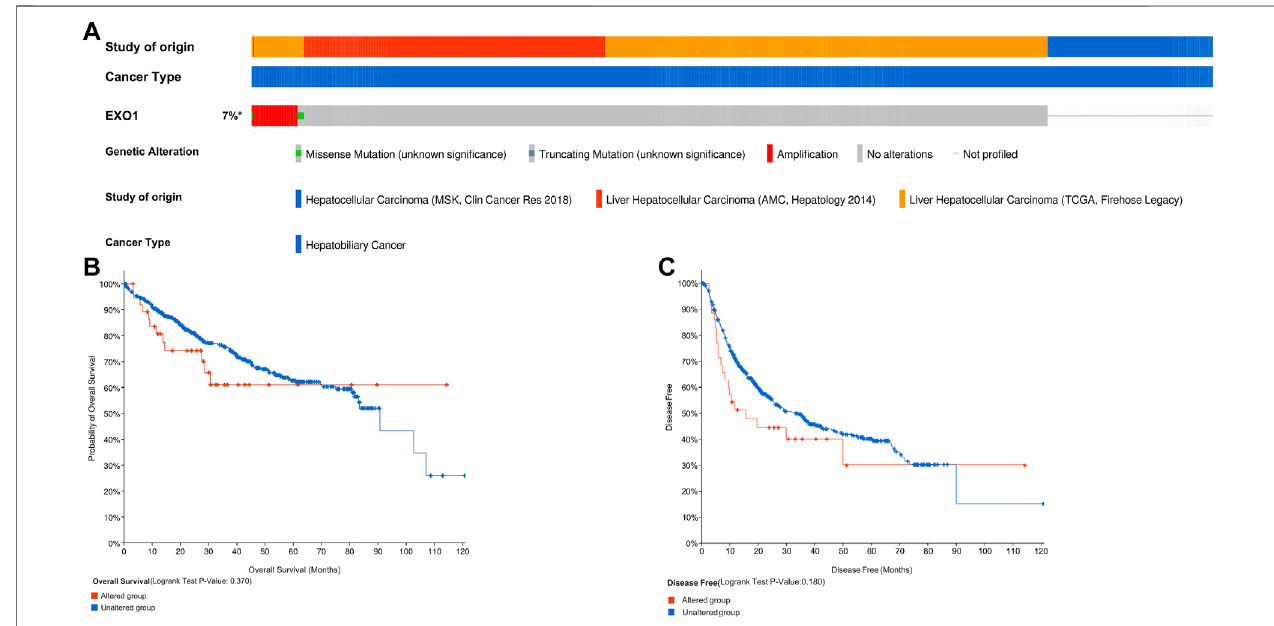
FIGURE 6 | EXO1 gene alterations are not associated with the survival outcomes in HCC. (A) OncoPrint visual summary of the alterations in the EXO1 gene. (B,C) Kaplan – Meier survival curves show the (B) overall survival and (C) disease-free survival rates of HCC patients with or without EXO1 gene alterations.